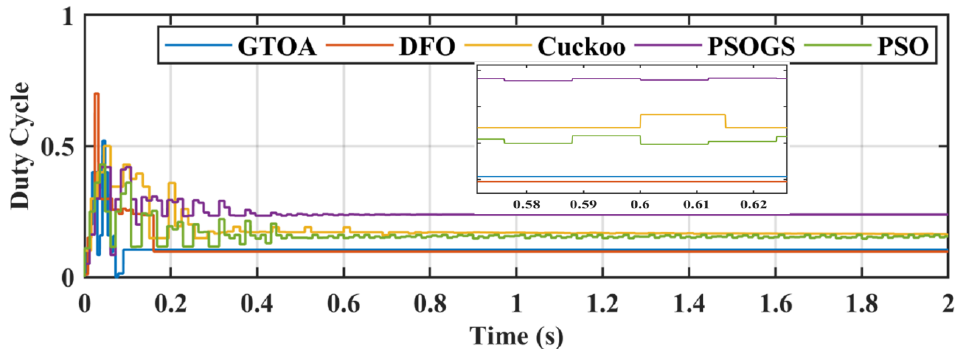
Figure 30. Zoomed-in comparison of duty cycle of GTOA.